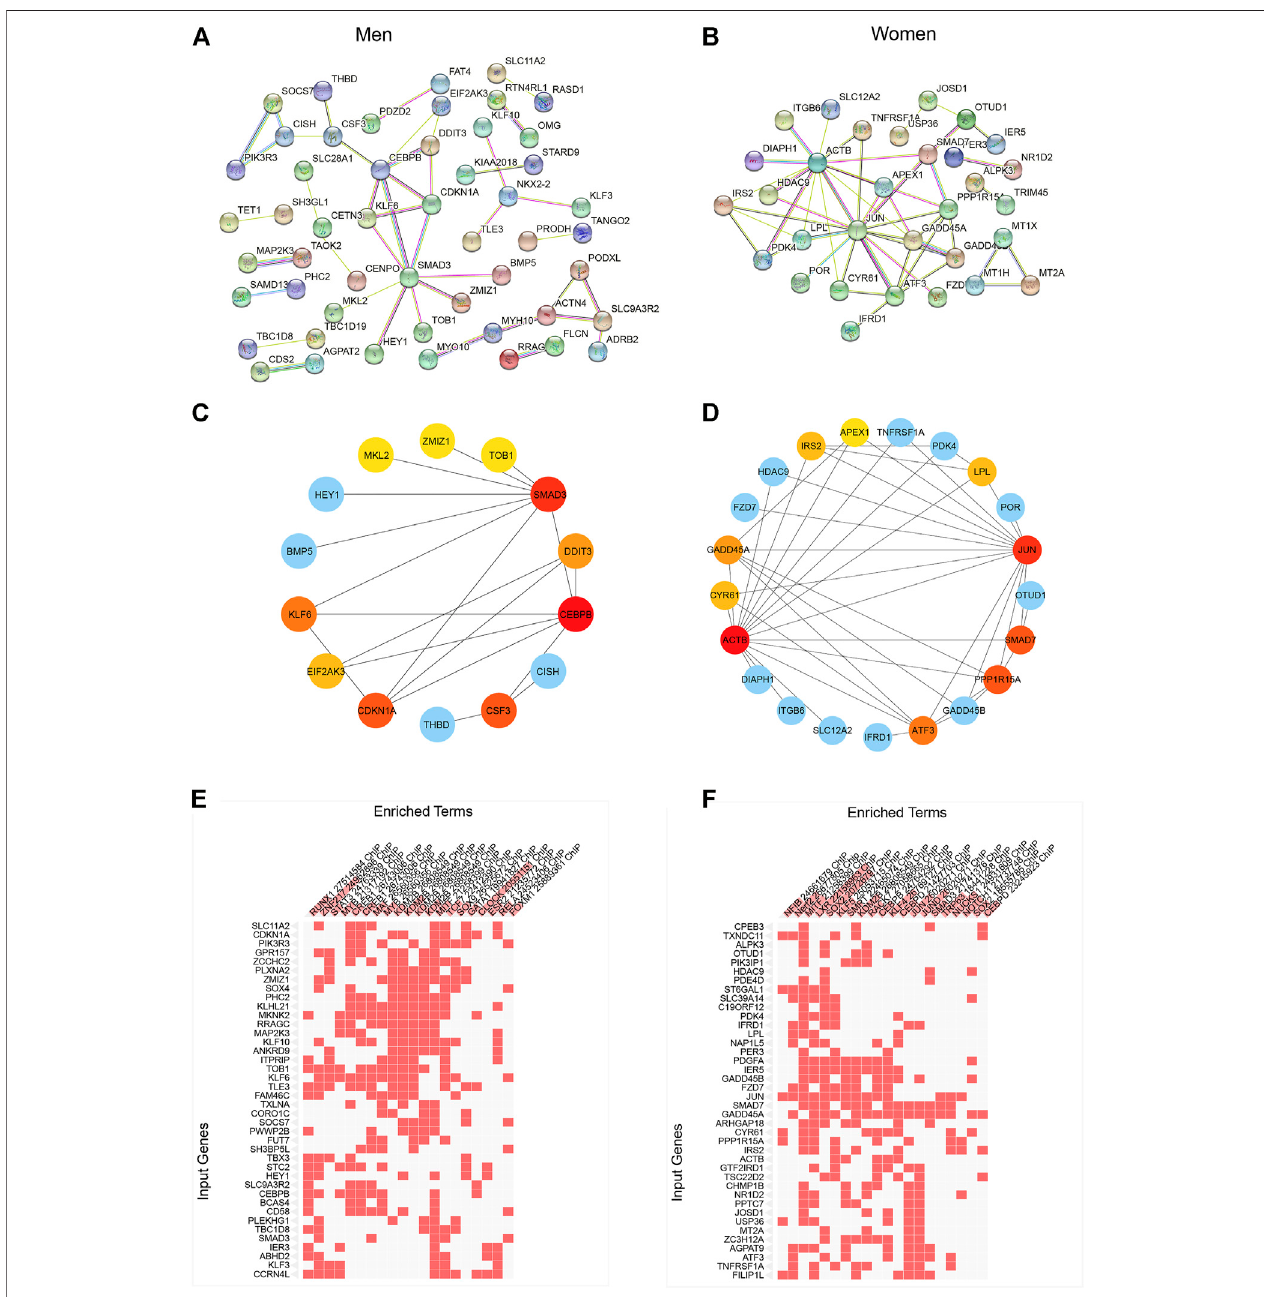
FIGURE3| ConstructionofPPInetworkandidenti fi cationofdifferentiallyexpressed genesinmenandwomen. (A) PPInetworkofdifferentially expressedgenesin men. (B) PPI network of differentially expressed genes in women. (C) Hub gene network of differentially expressed genes in men. (D) Hub gene network of differentially expressed genes in women. (E) Transcription factor enrichment of men-biased genes. (F) Transcription factor enrichment of women-biased